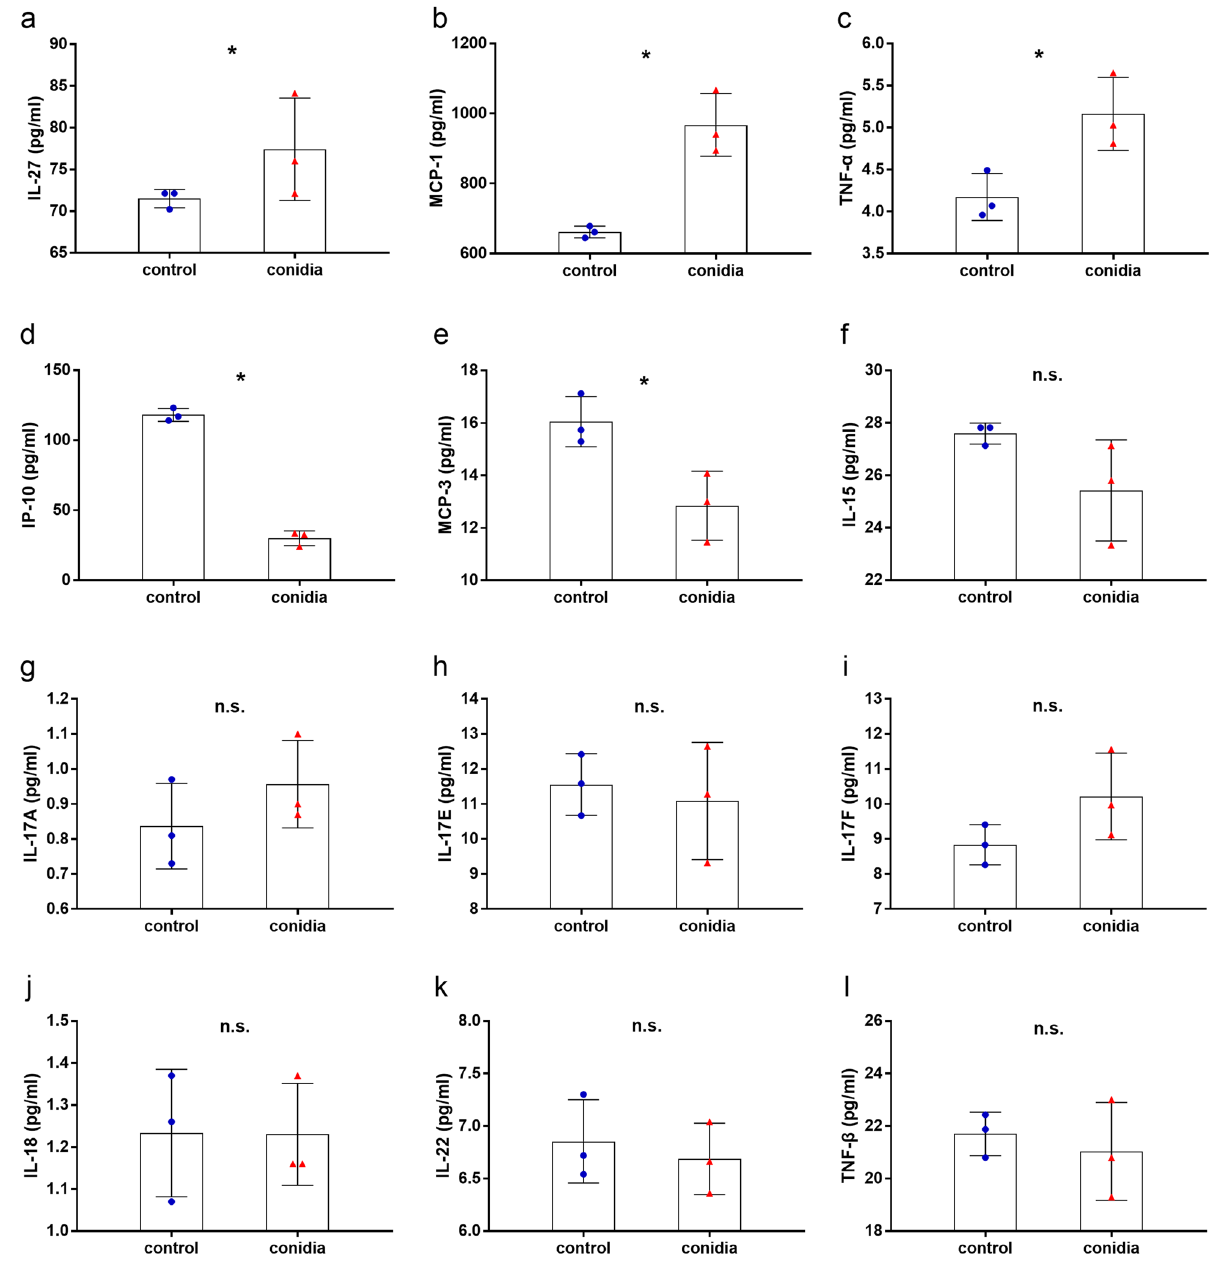
Figure 1. Release of proinflammatory cytokines from bronchial epithelial cells stimulated by A. fumigatus conidia. BEAS-2B cells were stimulated with resting conidia of A. fumigatus conidia at an MOI of 10 for 8 h. The secretion of IL-27, MCP-1, TNF-α, IP-10, MCP-3, IL-15, IL-17A, IL-17E, IL-17F, IL-18, IL-22 and TNF-β in supernatant of each group was detected ( a – l ). Data are presented as mean ± SD (n = 3). * P < 0.05; n.s . not significant; Student’s t